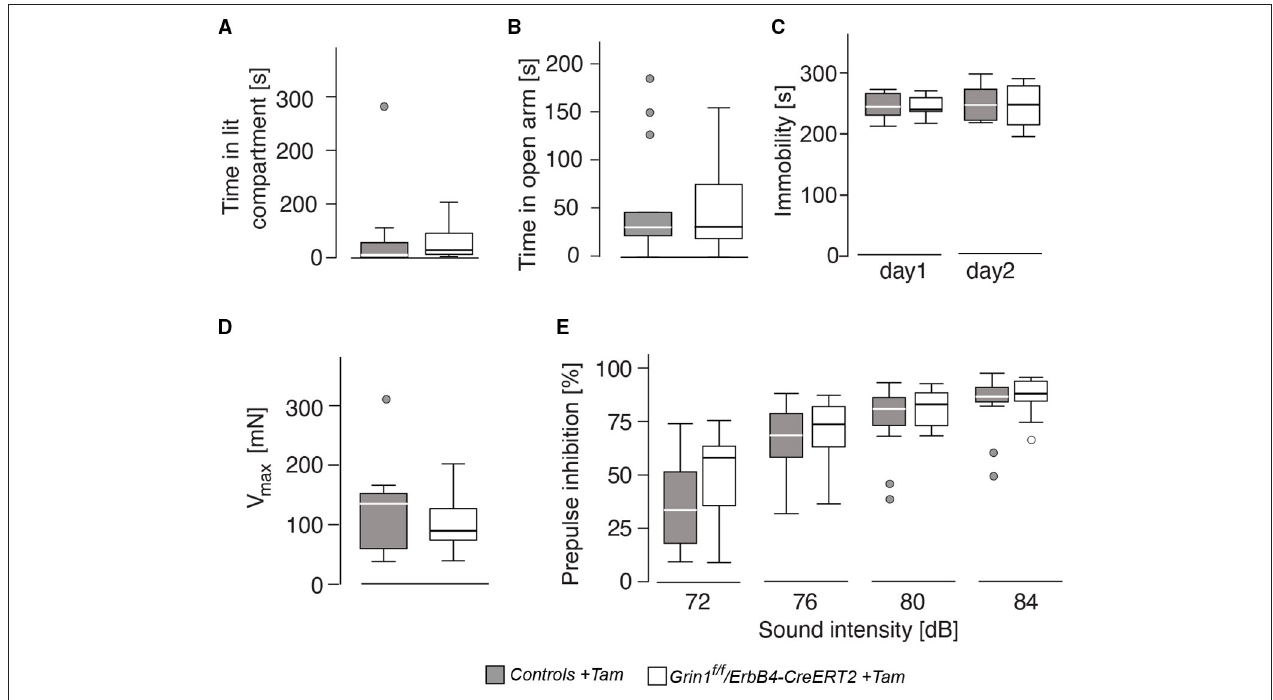
FIGURE 4 | The genetic manipulation did not lead to alteration in affective behavior and prepulse-inhibition of the acoustic startle response. (A) Time spent in the illuminated part of the dark-light box, (B) time spent on the open arm of the elevated o-maze, (C) immobility in the forced swim test, (D) acoustic startle response and (E) prepulse inhibition of the startle response. Group size n = 7. Data is represented as means +